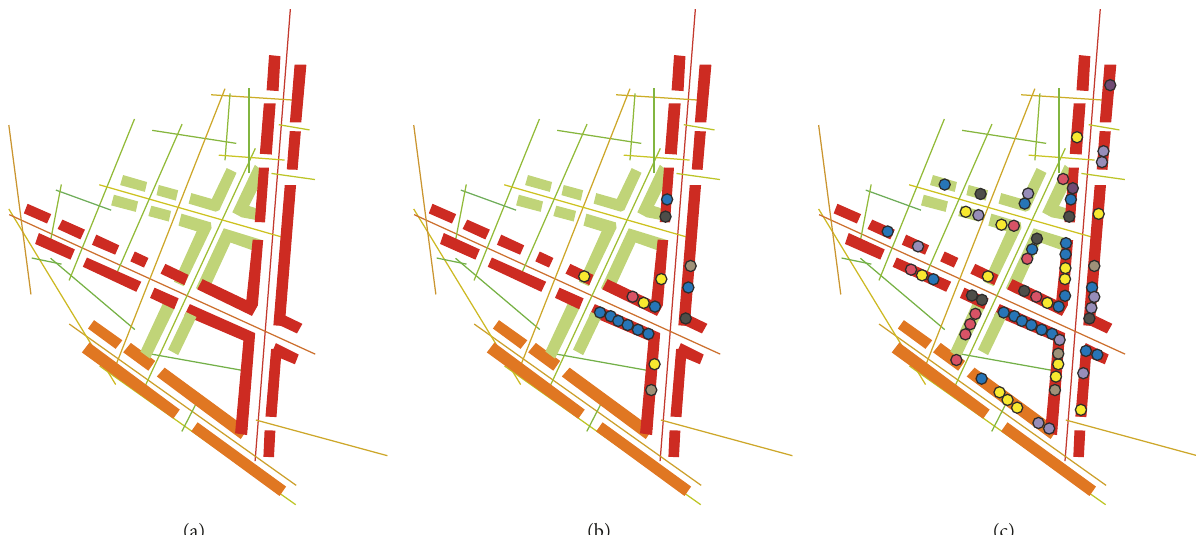
Figure 1: Differential space: like a code of instructions for collective action, urban space finds differentiation both physically , as hierarchies of accessibility and distribution of built form (a), and semantically , through actions performed in buildings and places ((b), (c)).